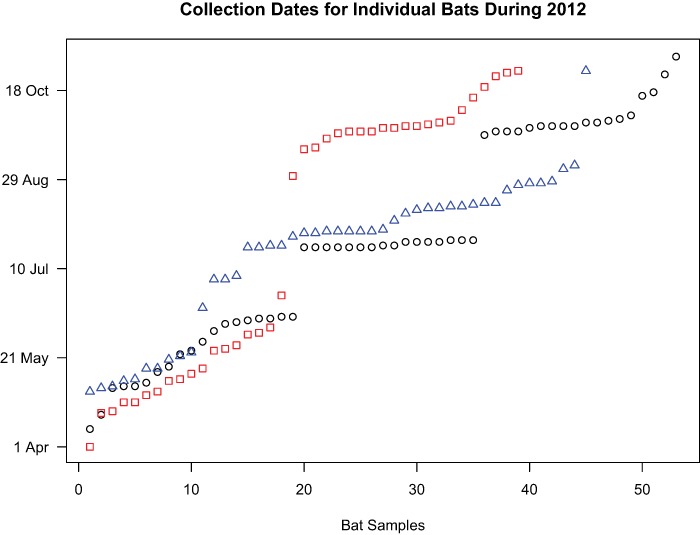
Collection dates of bats chosen for genetic analyses.Samples included in the study were selected in a manner that formed two temporal groups for L. noctivagans and L. cinereus (red squares and blue triangles, respectively) or three temporal groups for L. borealis (black circles). These clusters formed the basis for the AMOVA analysis.